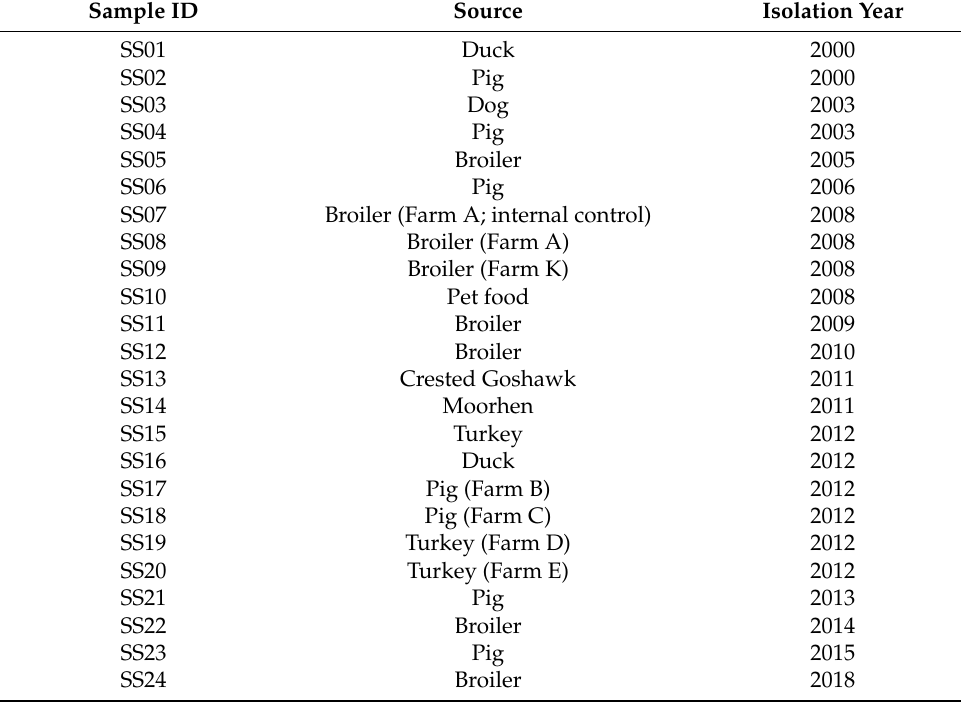
Table 1. S. enterica serovar Schwarzengrund strains used in this